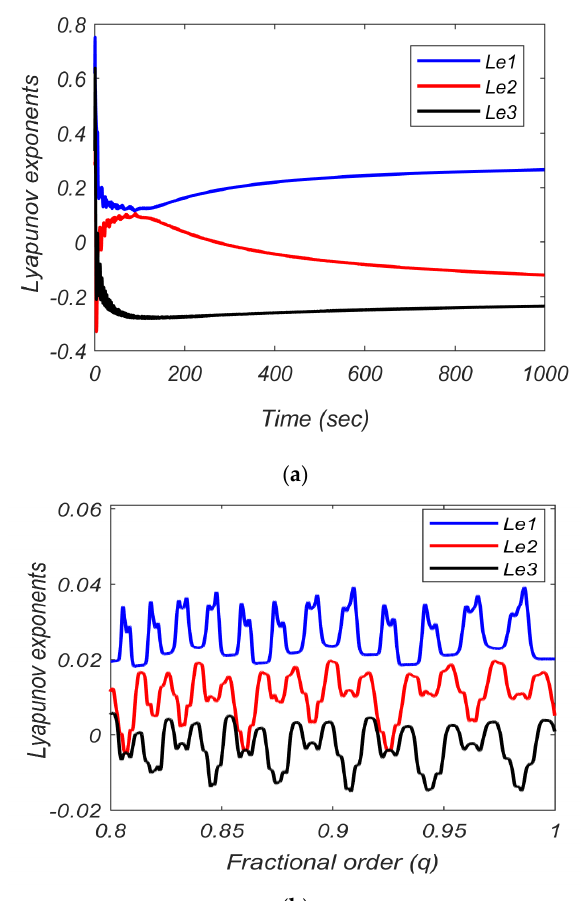
Figure 3. Lyapunov exponents: ( a ) with respect to time; ( b ) with respect to changing fractional-order derivative value ( q ).